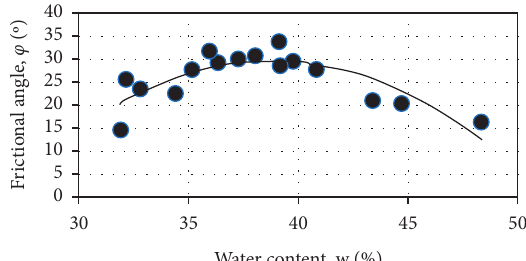
Figure 3: Highest cohesion value.